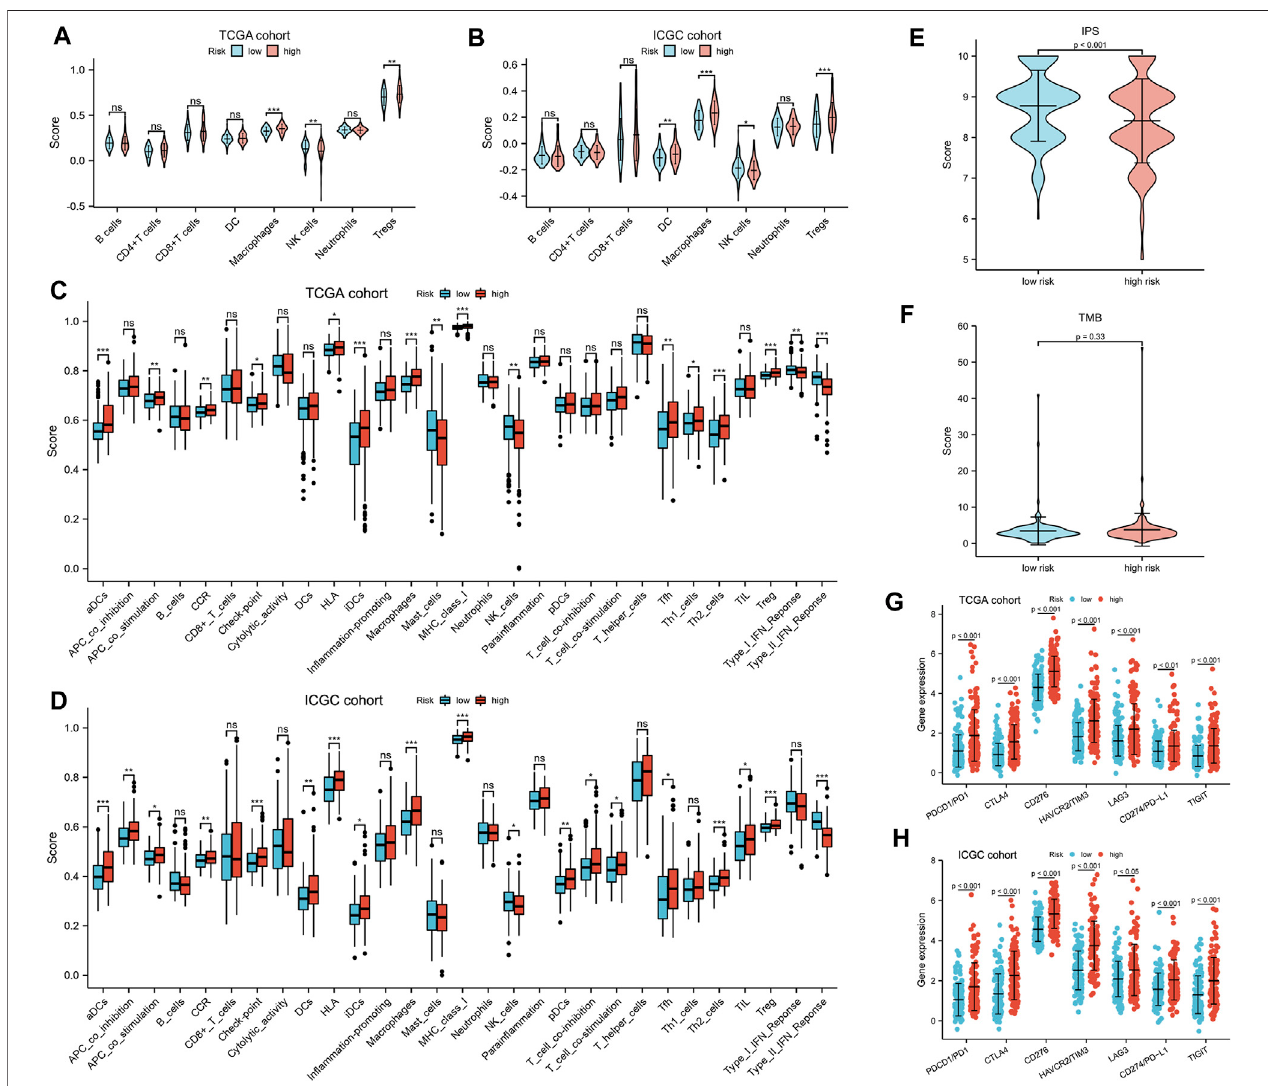
FIGURE 6 | Tumor immune microenvironment analysis. (A,B) The eight types of immune in fi ltration cells in different risk groups. (C,D) The ssGSEA scores of 16 immune cells and 13 immune-related functions between the high- and low-risk group. Adjusted p values were shown as ns, not signi fi cant; *, p < 0.05; **, p < 0.01; and ***, p < 0.001. The (E) IPS and (F) TMB in different risk subgroups. (G,H) The expression of CTLA-4, LAG-3, PD-1, TIGIT, TIM-3, CD276, and PD-L1 in different risk subgroups.